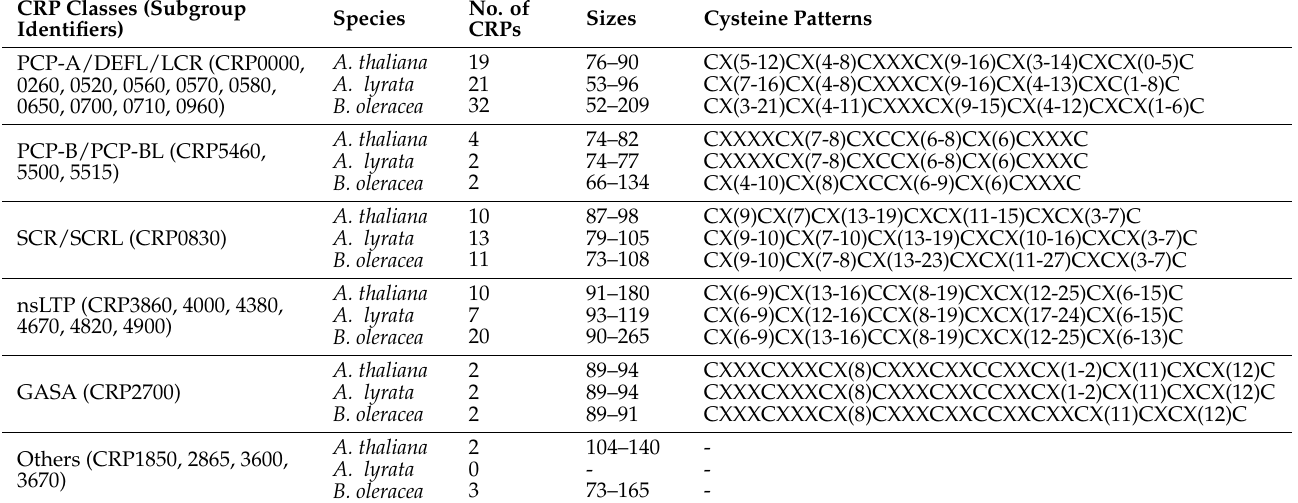
Table 2. Cysteine-rich protein (CRP) classes shared among the pollen coat proteomes of Arabidopsis thaliana , Arabidopsis lyrata , and Brassica oleracea . PCP-A, pollen coat protein A; DEFL, defensin- like protein; LCR, low-molecular-weight cysteine-rich protein; PCP-B(L), pollen coat protein B (-like); SCR(L), S -locus cysteine-rich (-like) protein; nsLTP, non-specific lipid transfer protein; GASA, gibberellic acid-stimulated Arabidopsis. The subgroup identifiers are assigned based on Silverstein et al. [44]. The numbers of CRPs belonging to each class were based on merged datasets among three replicates of each pollen coat proteome. Letter ‘C’ represents conserved cysteine residues. Letter ‘X’ represents any amino acid. Numbers in brackets represent the range of residue numbers between